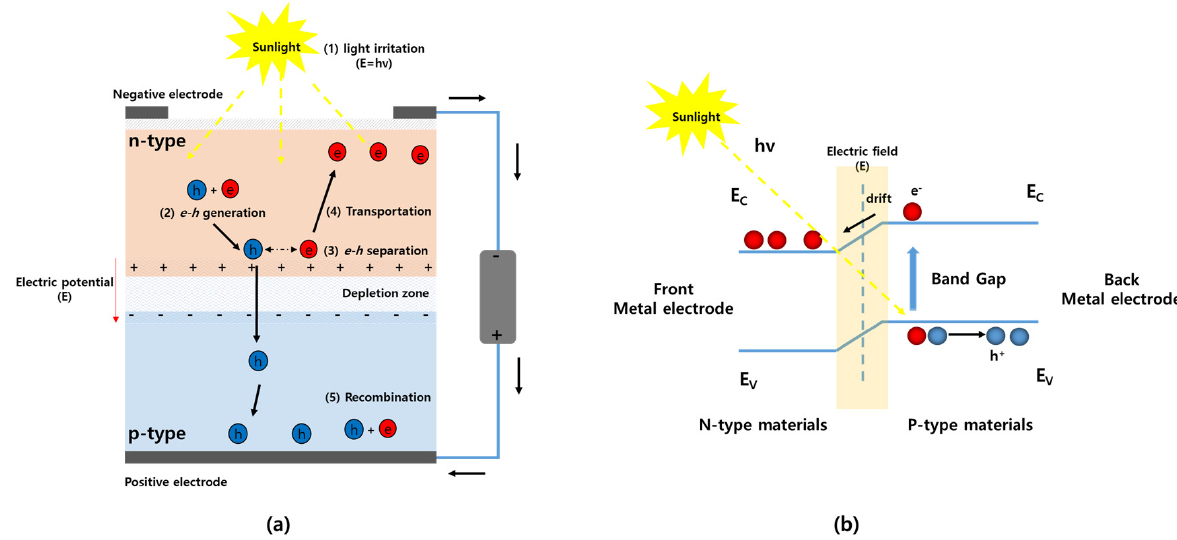
Figure 1. ( a ) working principle of solar cell with p-n junction structure and ( b ) loss mechanism in standard p-n junction solar cells.